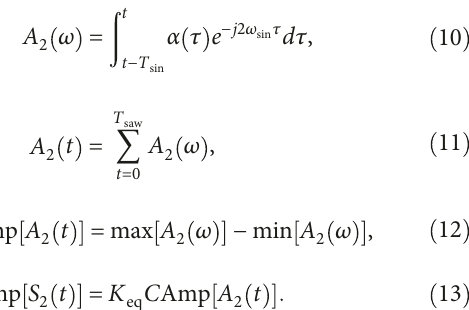
Figure 3: Inside view of the self-developed CO sensor based on the WMS